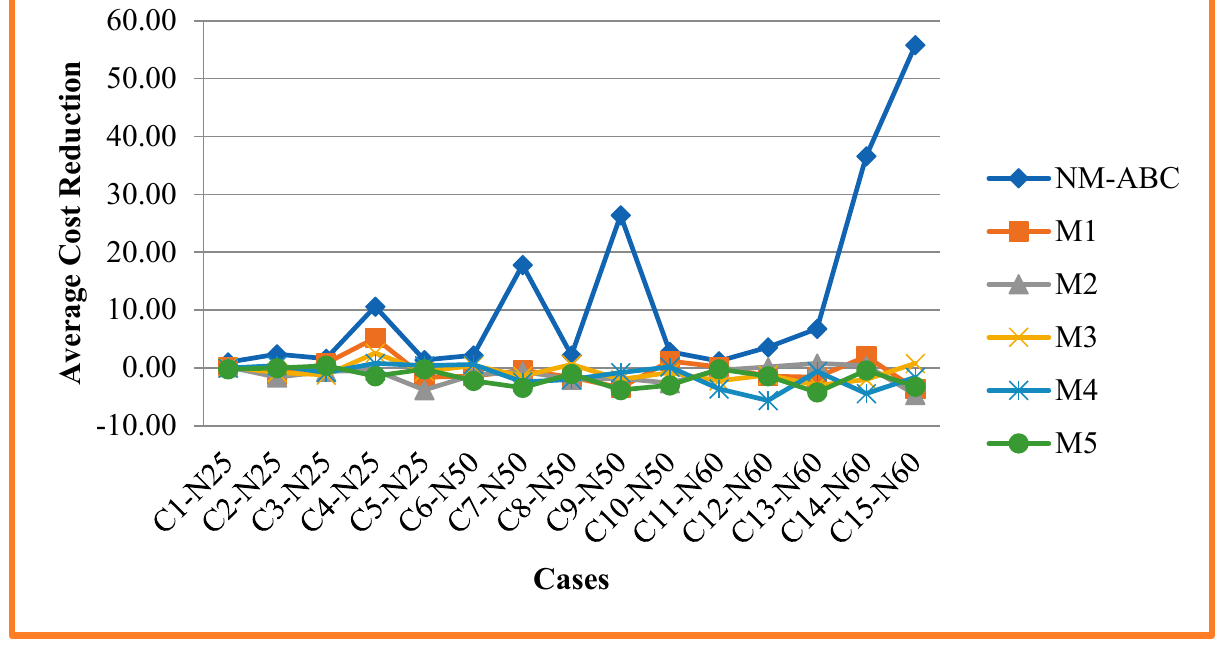
Figure 6. Analysis and Comparison of Average Cost Reduction.